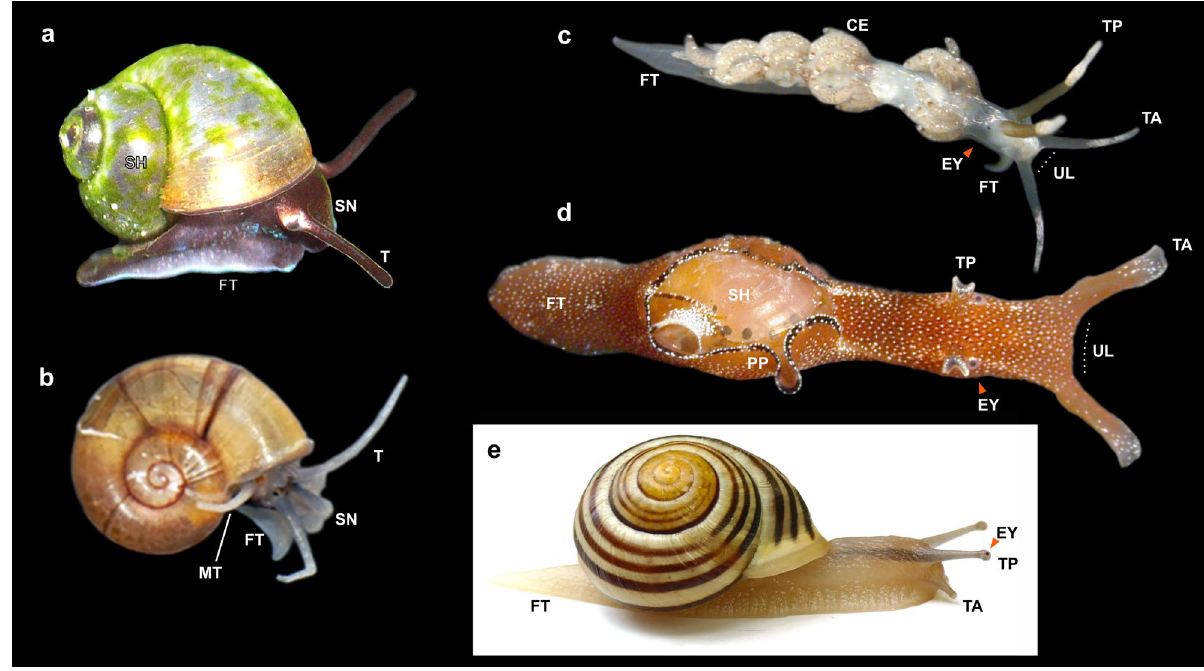
Figure 1. Comparative head-foot morphology of living Caenogastropoda and Heterobranchia. Macrophotographs of European species taken from above or right side. ( a , b ) Caenogastropoda and ‘lower’ Heterobranchia have one pair of smooth head tentacles and a short snout bearing the mouth at its tip. ( c–e ) Euthyneuran heterobranchs, in contrast, have one pair of anterior tentacles that form an upper lip above the mouth (labial/oral tentacles) and another separate pair of posterior tentacles (rhinophores or ommatophores). ( a ) Freshwater caenogastropod Sadleriana bavarica (2.2 mm in shell diameter; family Hydrobiidae). ( b ) Freshwater ‘lower’ heterobranch Valvata cristata (3 mm; Valvatidae); unpaired tentacle on right side is secondary and non-cephalic. ( c ) Marine nudibranch Favorinus branchialis (6 mm in body length; Favorinidae) with modified rhinophores; anterior foot extended to form tentacle-like projections. ( d ) Juvenile of marine euopisthobranch Aplysia punctata (10 mm; Aplysiidae) with two pairs of enrolled tentacles. ( e ) Terrestrial panpulmonate Cepaea hortensis (20 mm; Helicidae) with stalked eyes on posterior tentacles. Abbreviations: CE, cerata (dorsal appendages of mantle); EY, eye (highlighted by orange arrowheads); FT, foot; MT, unpaired tentacle extending from mantle margin; PP, parapodia (lateral extensions of foot covering shell); SH, shell; SN, snout; T, head tentacles; TA, anterior head tentacles; TP, posterior head tentacles; UL, upper lip or velum above mouth (highlighted by dotted